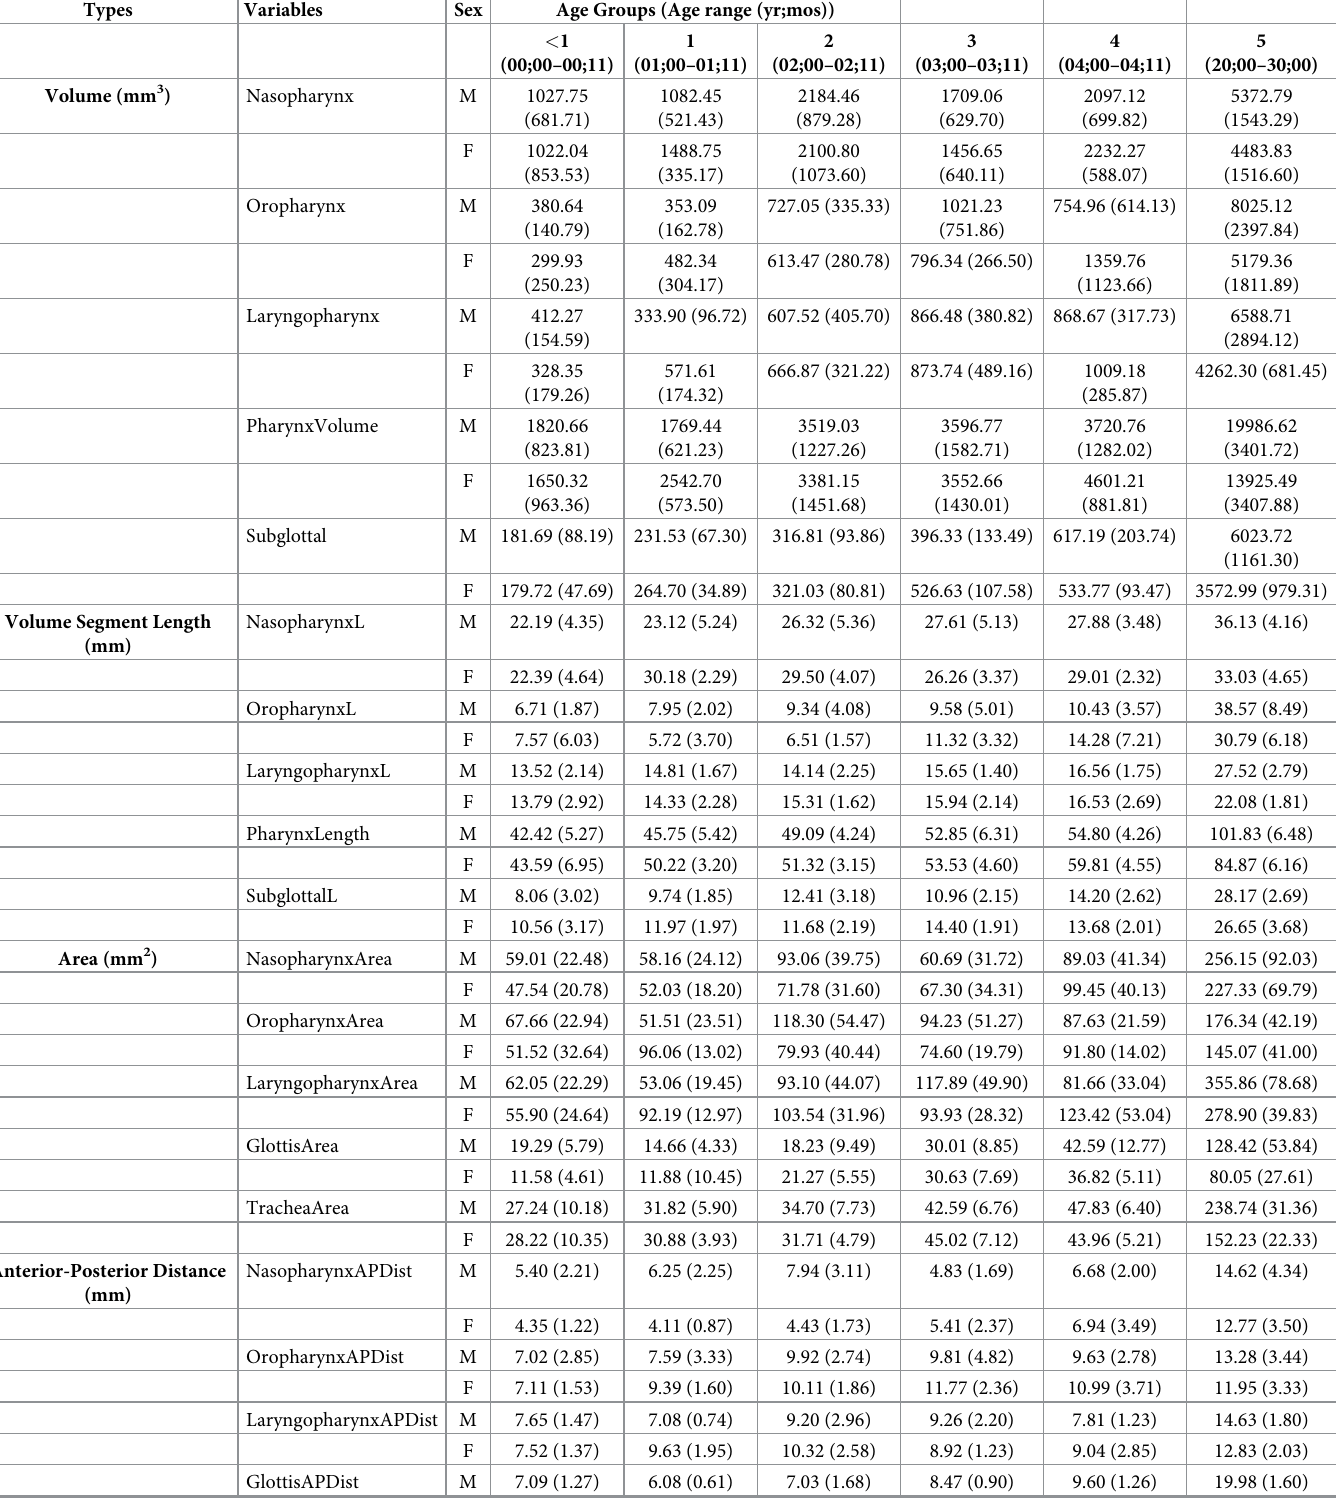
Table 7. Age-specific mean (standard deviation) of the different measurement types for each pharyngeal region.